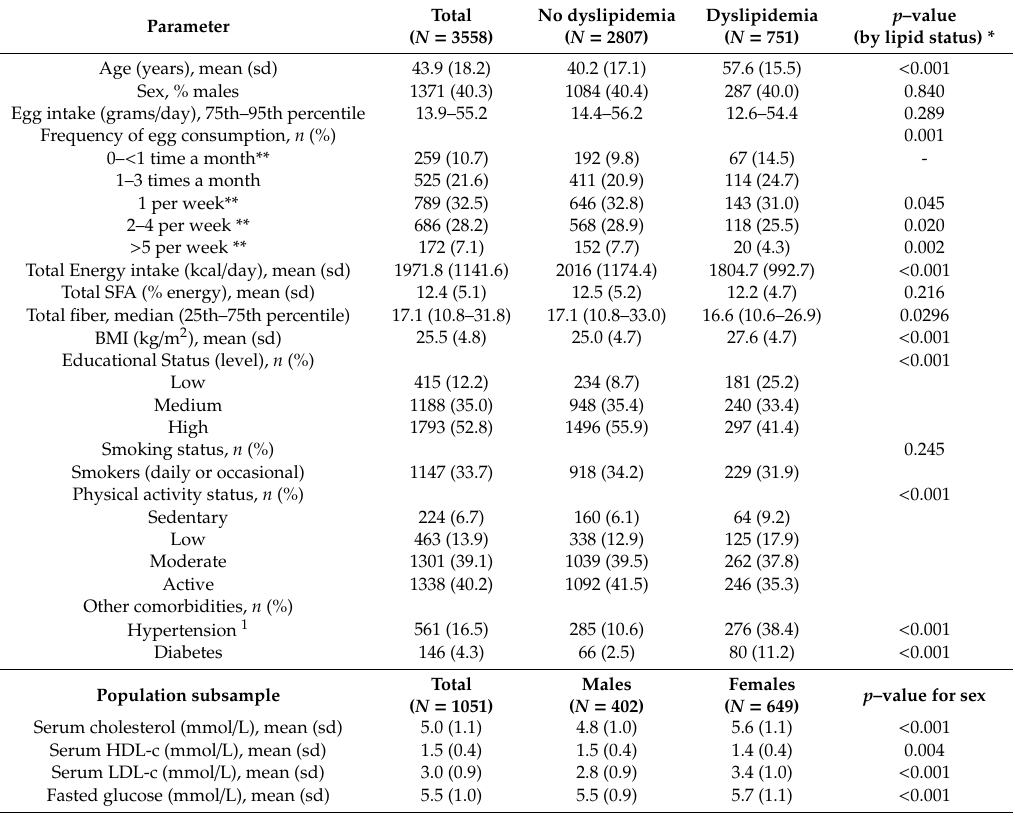
Table 2. Baseline and demographic characteristics of the study adult participants by lipid status. Total Parameter ( N = 3558)